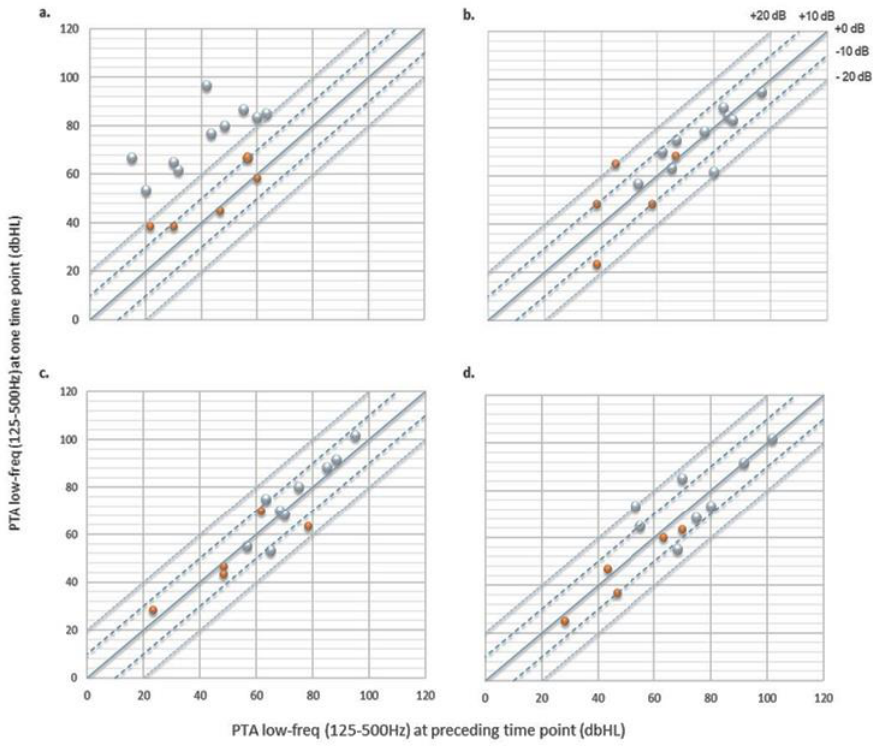
Figure 2. Scatterplots of low-frequency (125–500 Hz) pure-tone audiometry (PTA) at one time point vs. preceding time point: ( a ) activation vs. pre-operative thresholds ( n = 15); ( b ) 1M after activation vs. activation thresholds ( n = 15); ( c ) 3M vs. 1M after activation thresholds ( n = 14); ( d ) 6M vs. 3M after activation thresholds ( n = 13). The solid line indicates no change in PTA, the dashed lines refer to 10 dB shift in PTA and the dotted lines to 20 dB shift in PTA. Orange circles indicate participants with complete hearing preservation and grey circles participants with partial hearing preservation as defined in the HEARRING group [18]. Table 3. Average hearing loss over follow-up vs. preceding visit (dB HL) up to 6 months follow-up ( n = 13) in both full range and low-frequency pure-tone audiometry. Time